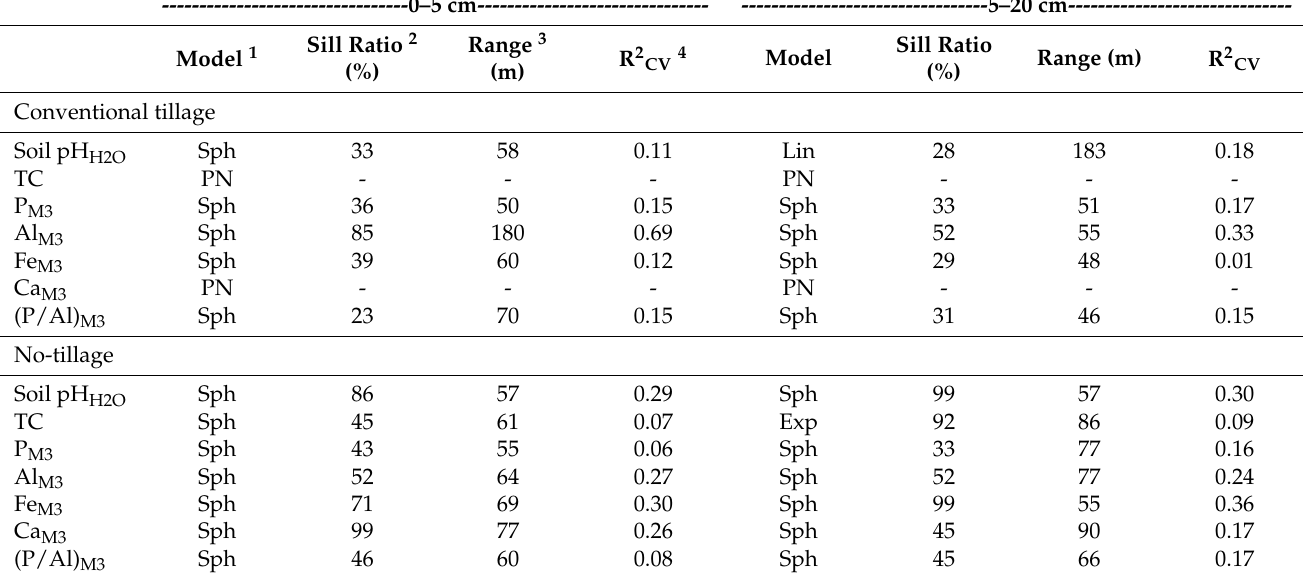
Table 2. Geostatistical parameters of the soil chemical properties for two soil layers (0–5 cm and 5–20 cm) from the conventional and no-tillage